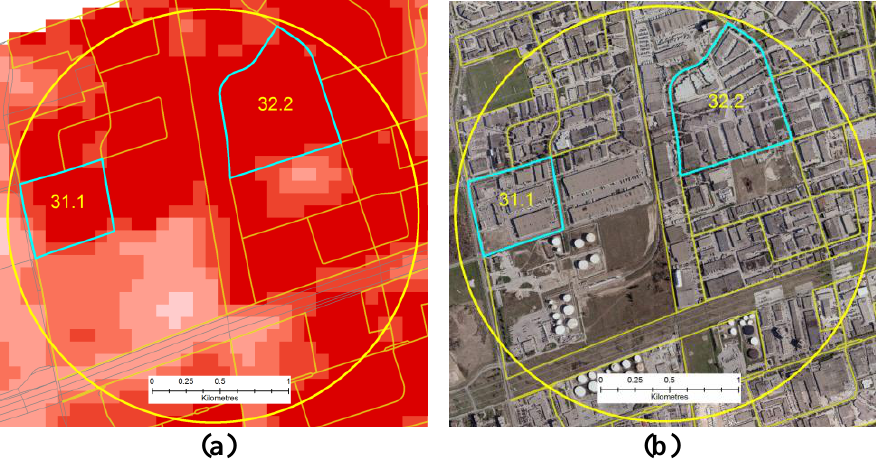
Figure 5. Neighborhood-level perspective on resource/industrial land use showing increase in mean surface temperature as polygon size increases. (a) Resource/industrial polygons overlaid on surface temperature; (b) orthophoto for